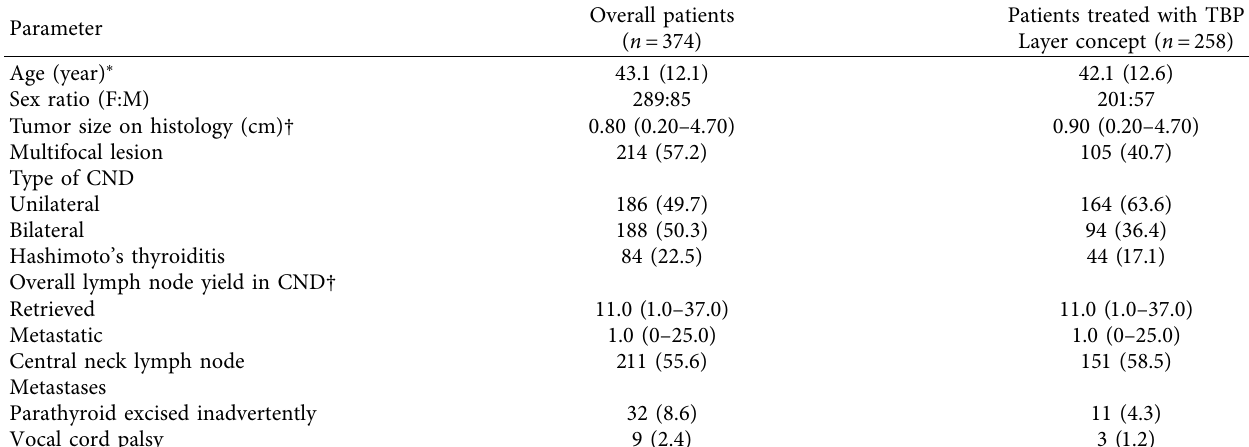
Table 1: Patient